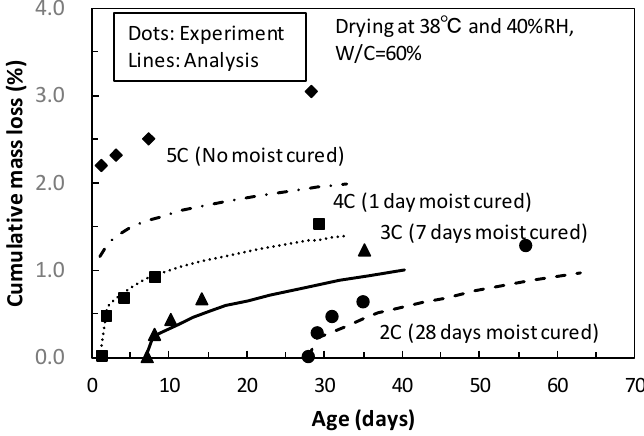
Figure 18. Comparison of weight loss based on the modified model (W/C = 60%) [29].